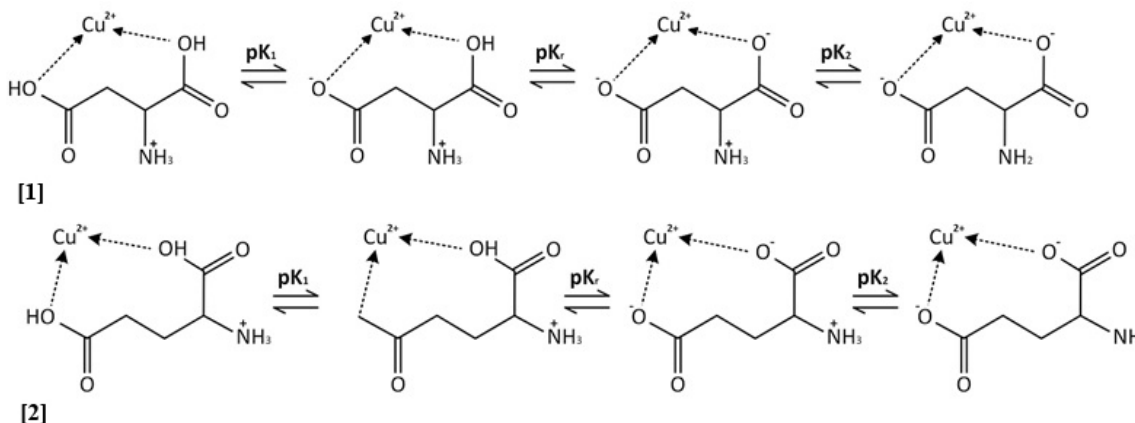
Figure 2 - Structural forms: L-aspartate-Cu (II) [ 1 ] and L-glutamate-Cu (II) [ 2 ] in aqueous medium.